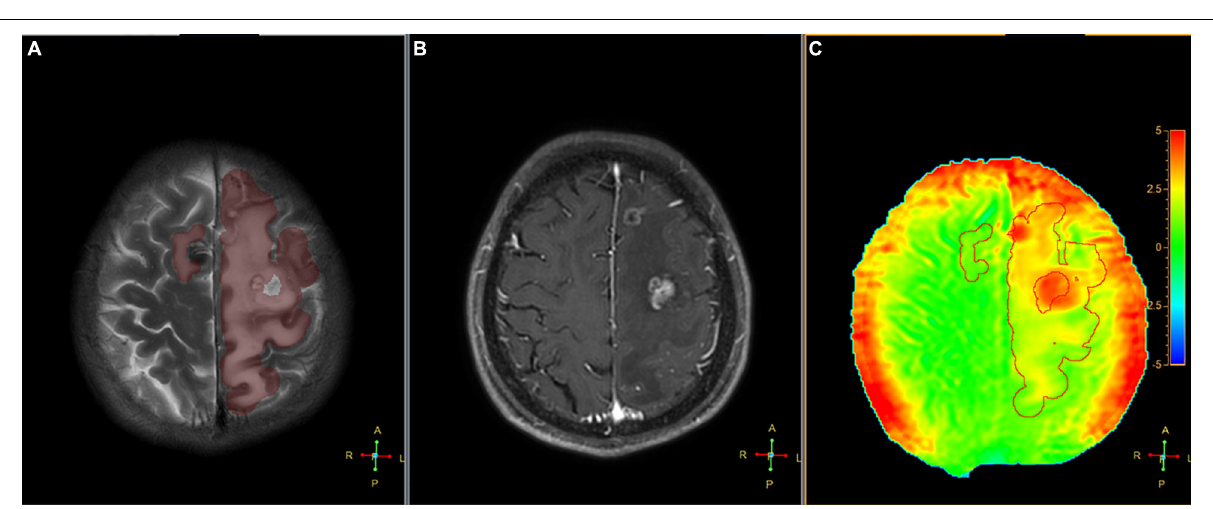
Frontiers in Neuroscience |